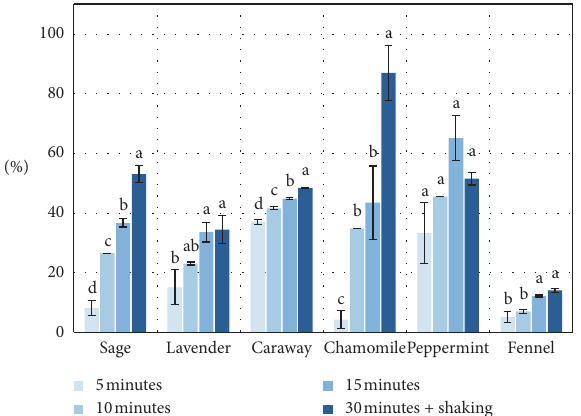
Figure 4: Efficiency of the process of primary brewing for the isolated essential oil (%). Data are shown as mean ± SD. Different letters (a, b, c, etc.) show a significant difference with p < 0 . 05.